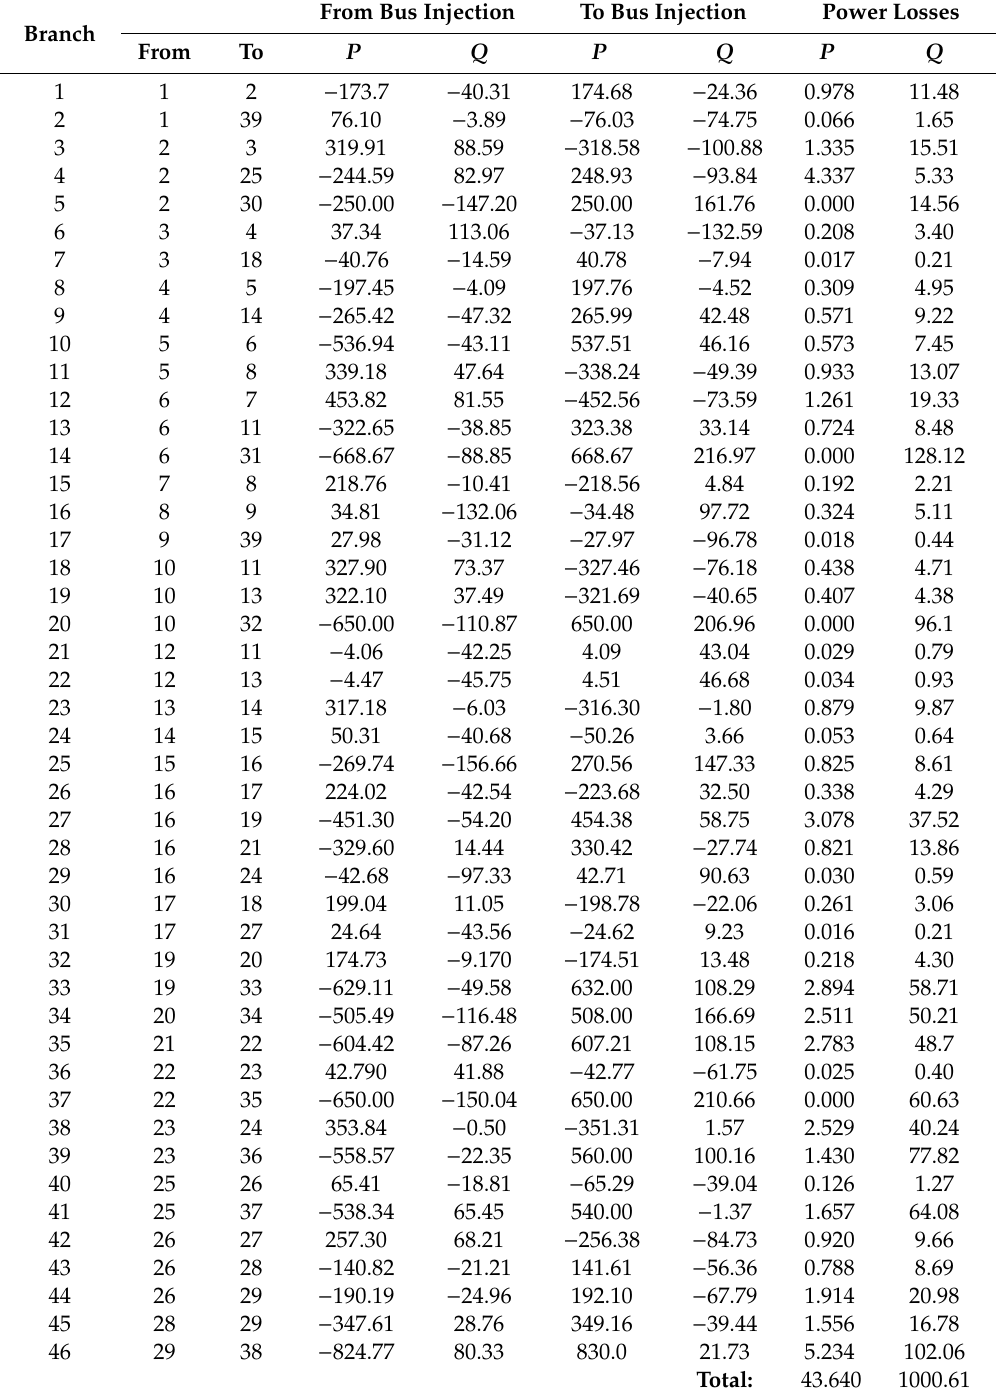
Table A34. Results of AC PF calculations in Case 7-1. AC branch